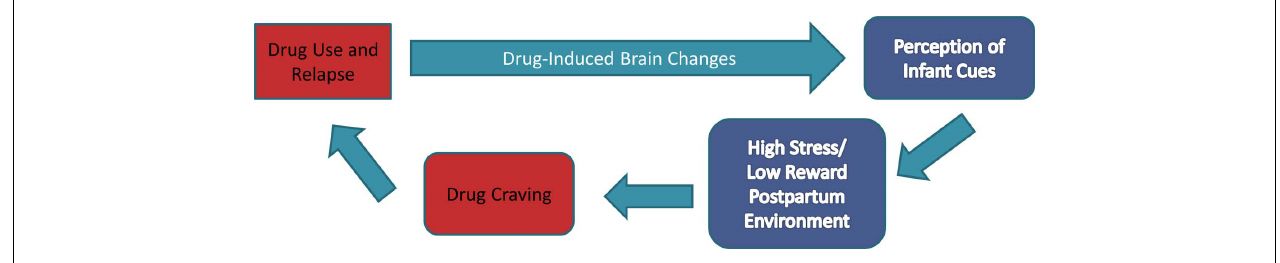
infant cues being attenuated, replaced by a more stressful neurophysiological response.This stress response to infant cues may increase craving for drugs of abuse, promoting drug seeking and relapse in abstinent mothers, and perpetuates the cycle of neglect.